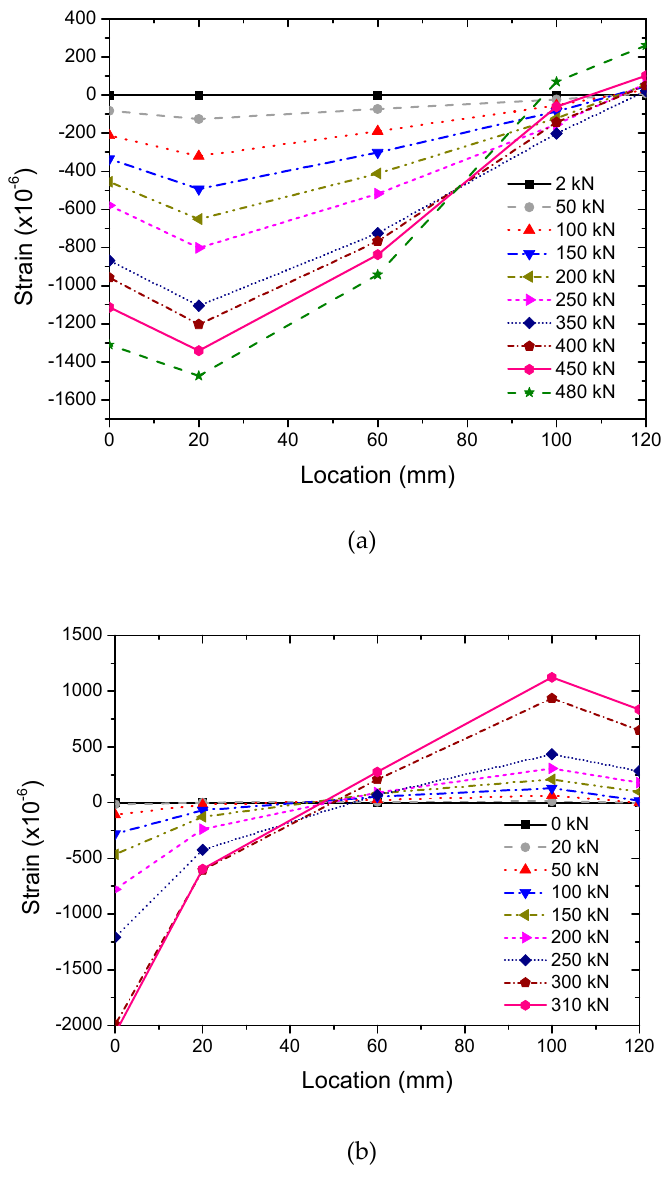
Figure 10. Load-strain response: ( a ) non-corroded column, and ( b ) corroded column.